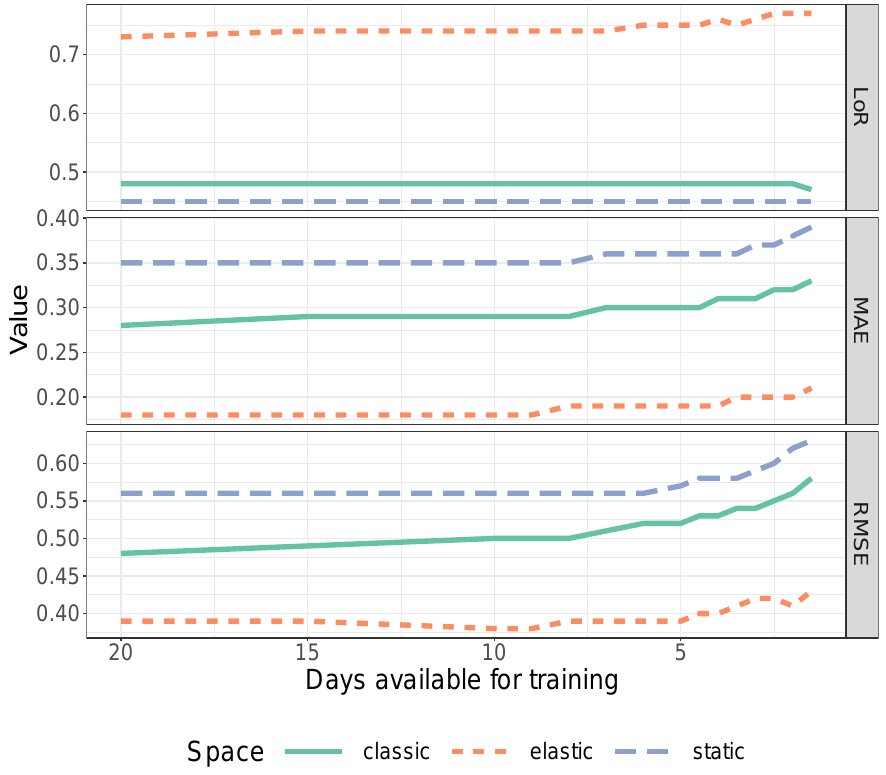
Figure 9. Performance evaluation of the MC-P model based on the classic, static, or elastic state space structure with respect to the availability of data in terms of days of historic train operation